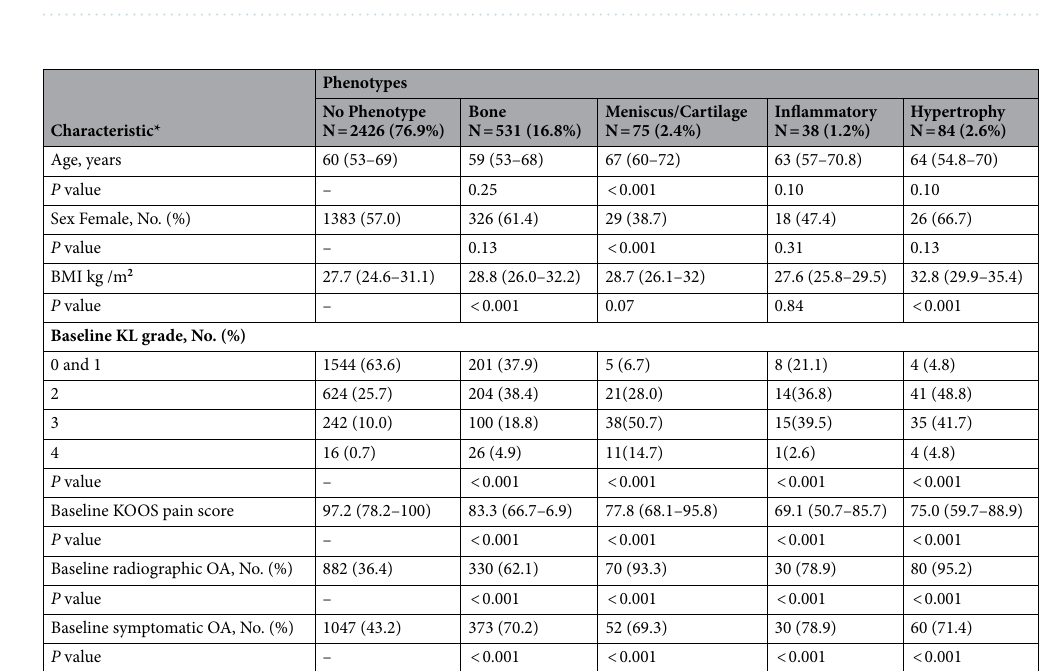
Figure 2. Flow chart of subject selection for phenotype analyses. BL: baseline, KLG: Kellgren Lawrence grading, ROA: radiographic OA, M/C: meniscus/cartilage, I: Inflammatory, H: hypertrophy.